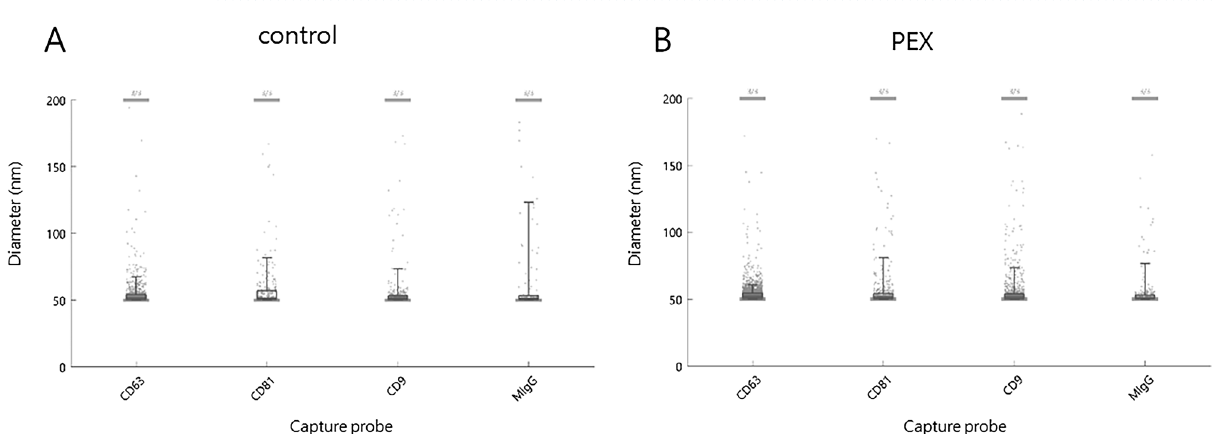
Figure 2. Quantitative exosome size distribution ( A ) Representative size distribution of AH control exosomes captured by the tetraspanin capture probe, including CD63, CD81, CD9, and MIgG is shown (55 ± 10 nm for CD63, 58 ± 17 nm for CD81, 55 ± 15 nm for CD9, and 62 ± 27 nm for MIgG). ( B ) Representative size distribution of AH exosomes from PEX patients captured (54 ± 60 nm for CD63, 56 ± 15 nm for CD81, 55 ± 13 nm for CD9, and 55 ± 13 nm for MIgG). Data are the mean ± standard